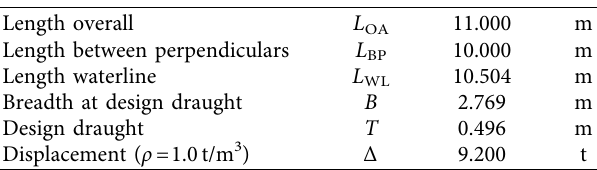
Figure 4: Body plan of the small passenger craft, showing the longitudinal buttocks (top), the transversal sections (middle), and the waterlines (bottom). Table 2: Main characteristics of the passenger